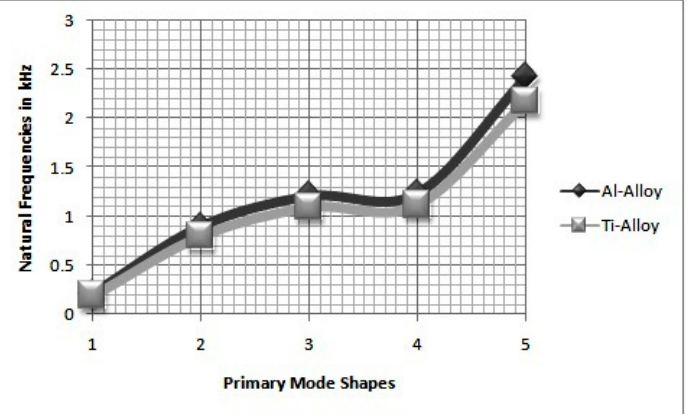
Figure 24. Comprehensive details of linear mode shapes versus natural frequencies for different alloys—UAV Wing.